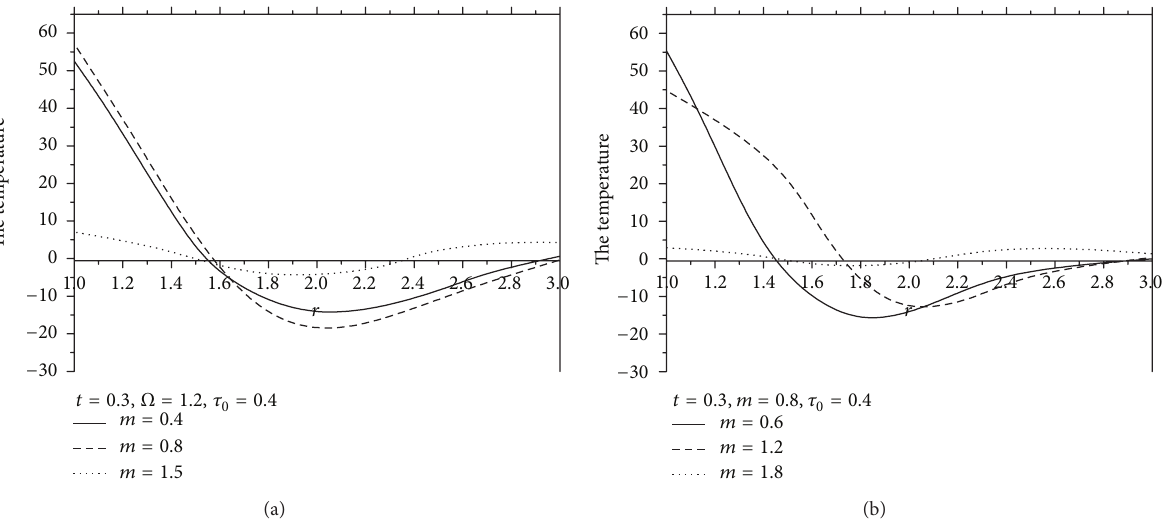
Figure 3: Variation of temperature 𝜃 with radius 𝑟 (thermoelastic diffusion nonhomogeneity medium).